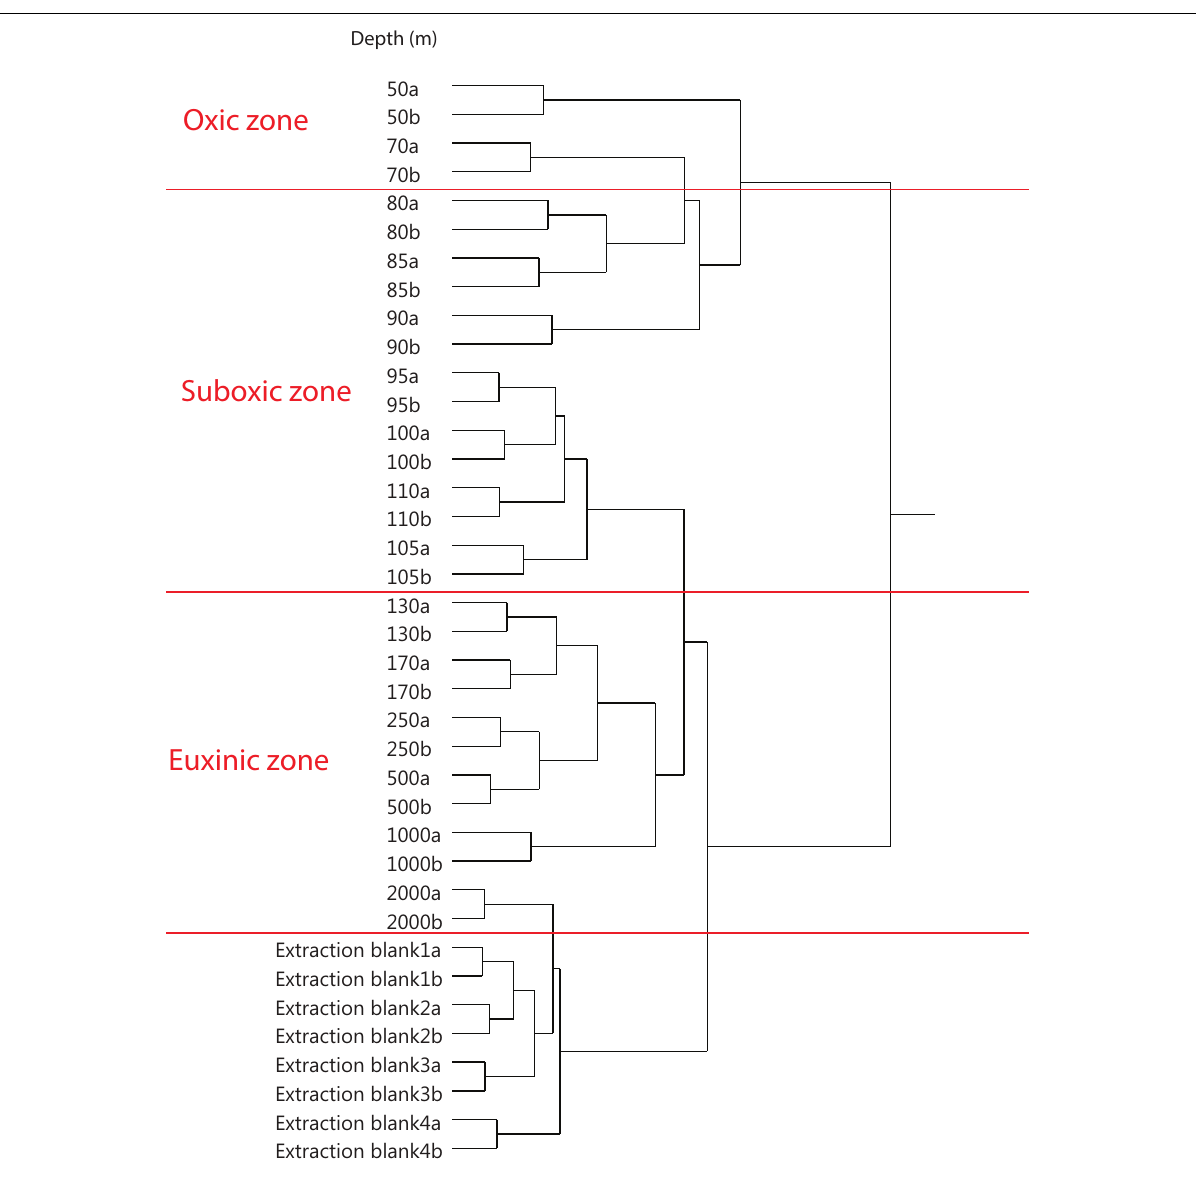
FIGURE 1 | A preliminary analysis, using average-neighbor hierarchical clustering (Ward method) of the 38 UHPLC-HRMS analyses (Black Sea water column SPM from 2013) and associated extraction blanks. Clustered by similarity in distribution of lipidome components ( n = 14,648), as extracted by MZmine software. Red annotations show the water column redox zones, as given in Table 1